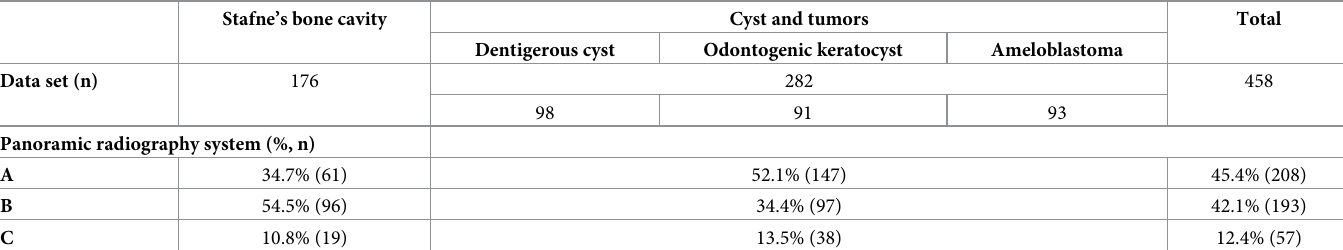
Table 1. Number of image data used in this study and the percentage of images according to individual panoramic radiograph.